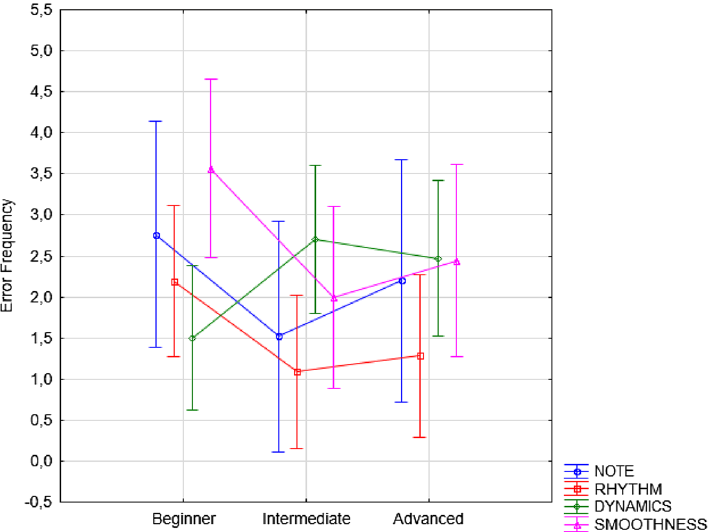
Figure 6. Error frequency observed for the three groups of students as a function of error type (regardless of the instrument played and learning condition). Error bars indicate standard errors.